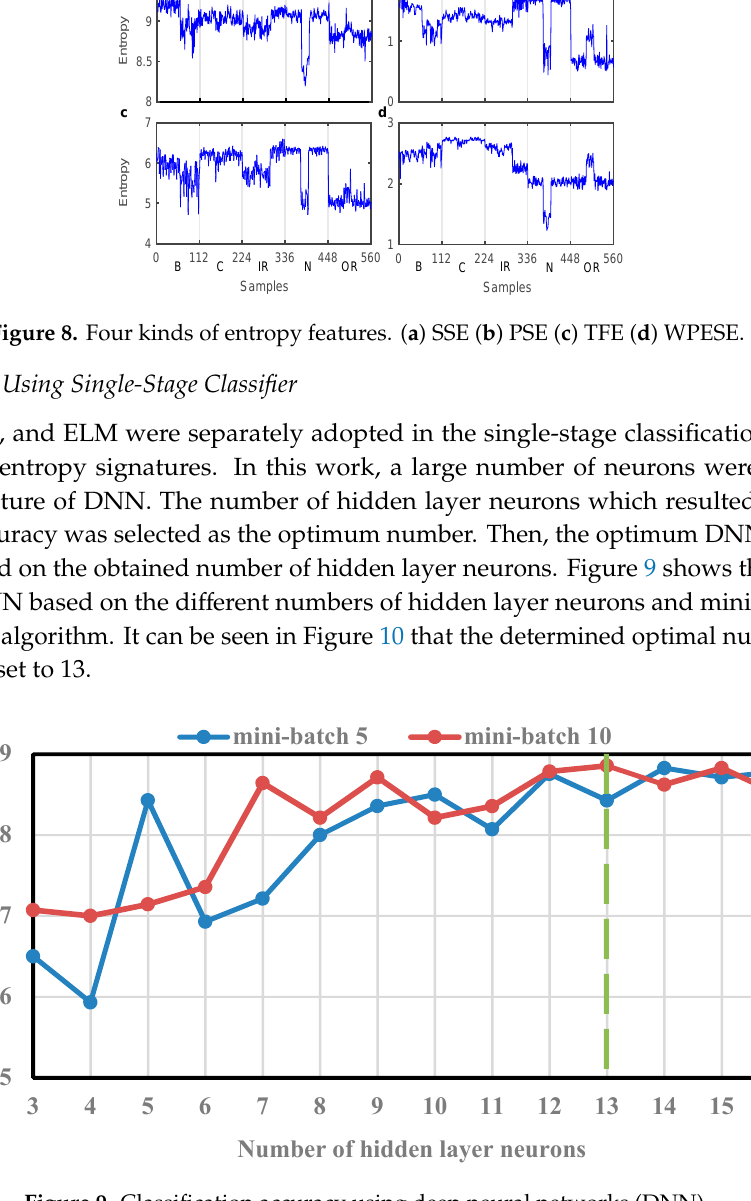
Figure 8. Four kinds of entropy features. ( a ) SSE ( b ) PSE ( c ) TFE ( d ) WPESE.